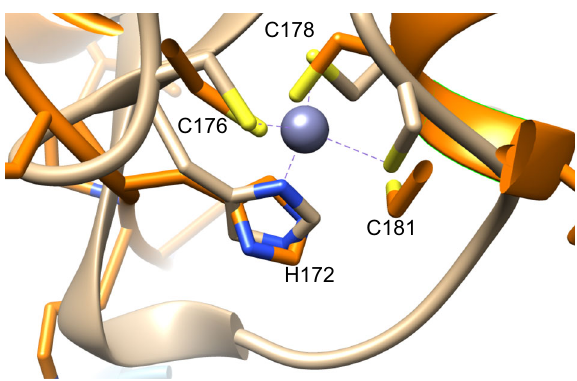
Fig. 5 Structure alignment of hTRPC5 and hURF1 is consistent with the identi fi cation of a TRPC5 zinc-binding site. Sequence alignment revealed that the Cys 3 -His 1 motif closely matched that of the PHD fi nger of human UHRF1 (an unrelated zinc-binding protein). Manual alignment was performed between hTRPC5 (orange) and hUHRF1 (PDB 3zvz; wheat). hTRPC5 residues forming the putative zinc-binding site have been